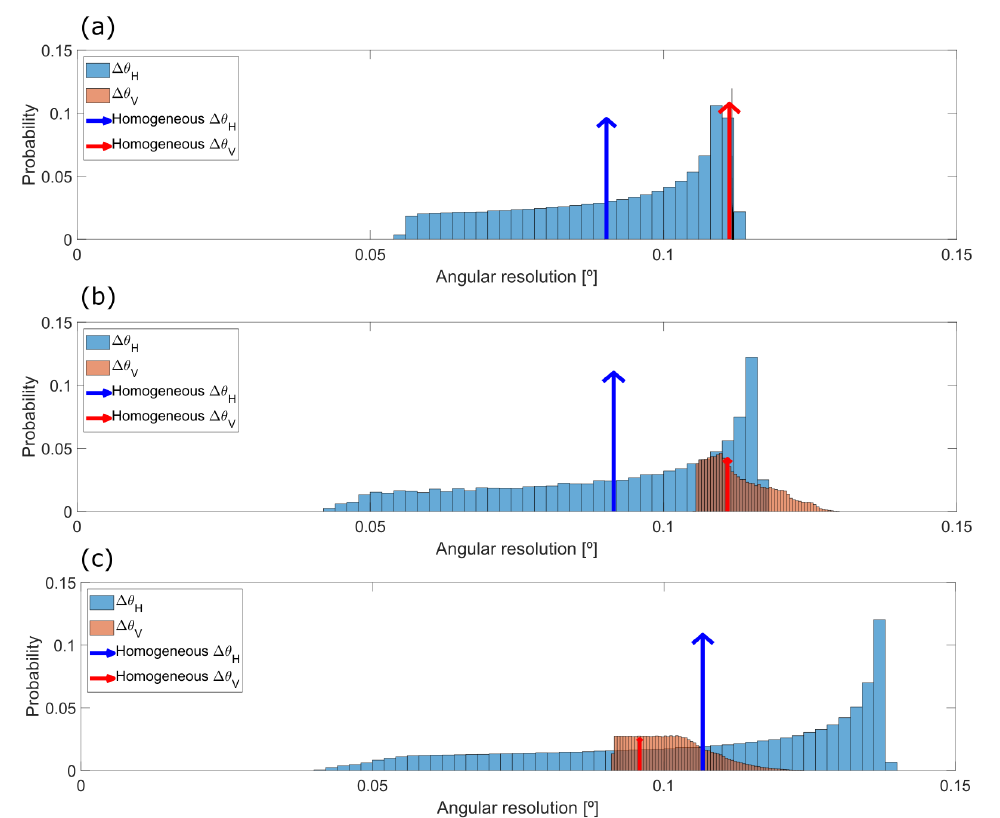
Figure 11. Comparison of both ( blue ) horizontal and ( red ) vertical resolution variation for the odd lines. ( a ) Simulation of the 30 × 20 ◦ FOV prototype with a sinusoidal dynamics for the fast scanning axis. ( b ) Results of the mapping function Map 3 for the 30 × 20 ◦ FOV prototype. ( c ) Results for the 50 × 20 ◦ .